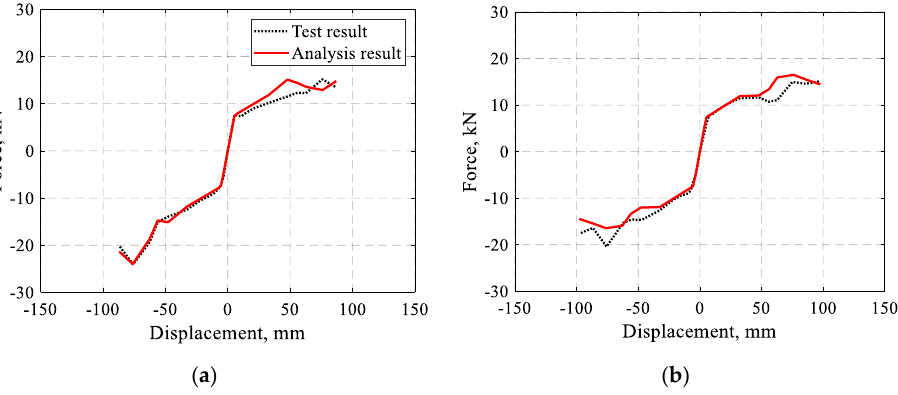
Figure 15. Comparison of analytical and experimental backbone curves: ( a ) ST600; ( b ) ST450.